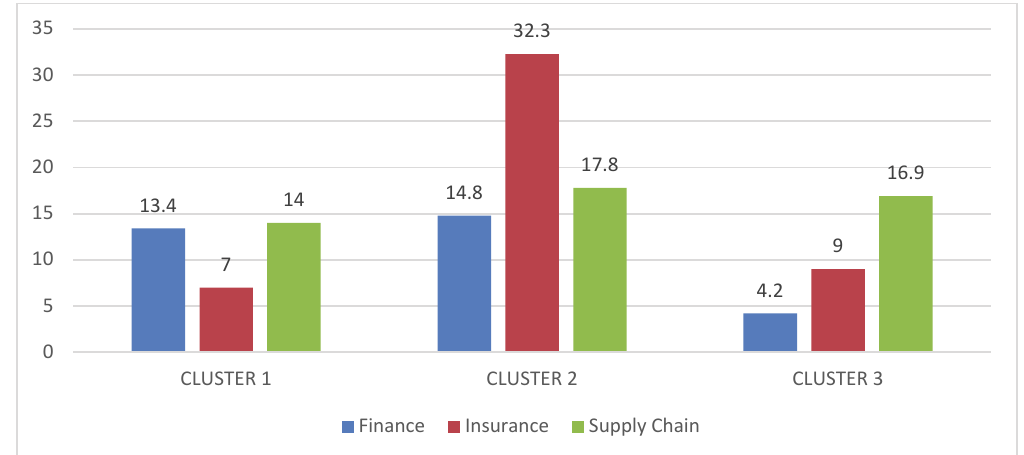
Fig. 2. Business Department Tracks Among the Three